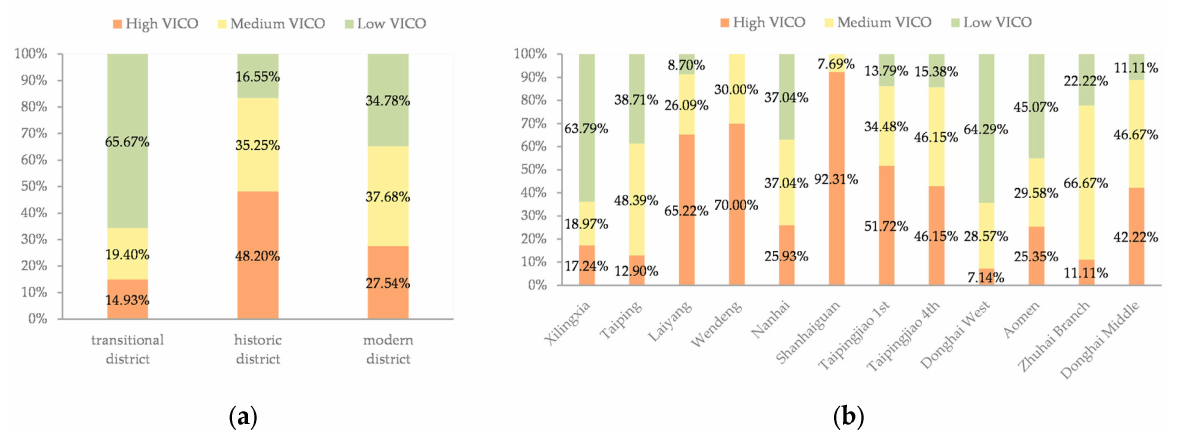
Figure 11. ( a ) Proportions of the 3 VICO levels in the three types of districts; ( b ) proportions of the 3 VICO levels in the 12 roads.